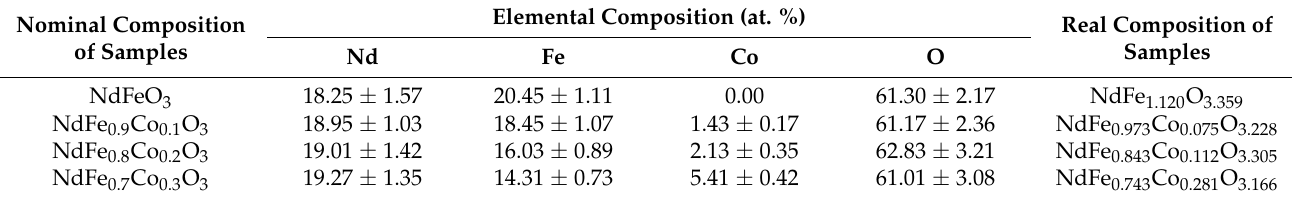
Table 2. EDX results of NdFe 1 − x Co x O 3 samples annealed at 750 ◦ C for 60 min.